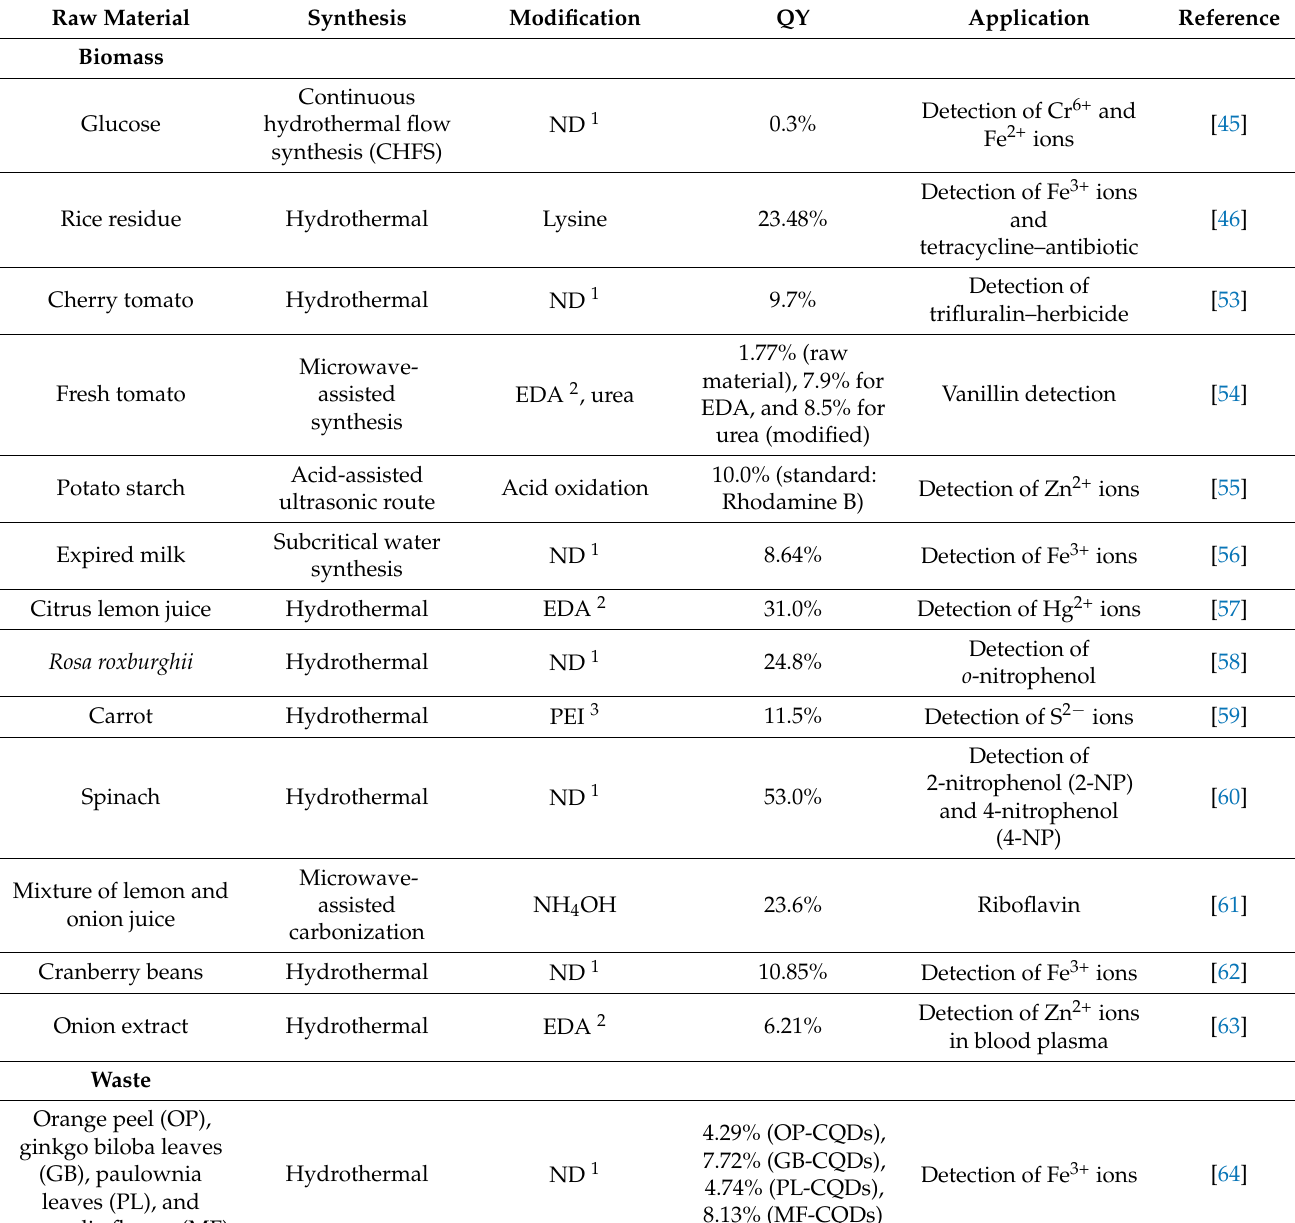
Table 2. CQDs prepared from the biomass and waste carbon sources and their properties and